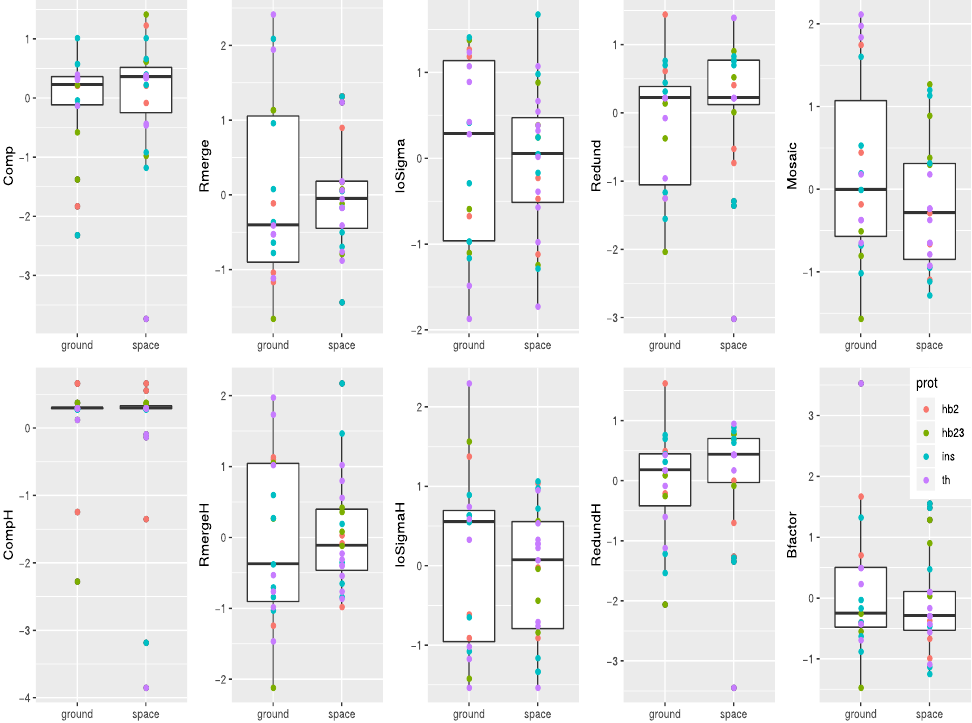
Figure 3. Minimum, lower-hinge, median, upper-hinge, and maximum for each of the ten analyzed indicators is shown as box plots of the values obtained from the two (space/ground) populations. The individual values are over-plotted as circles colored according to the protein.